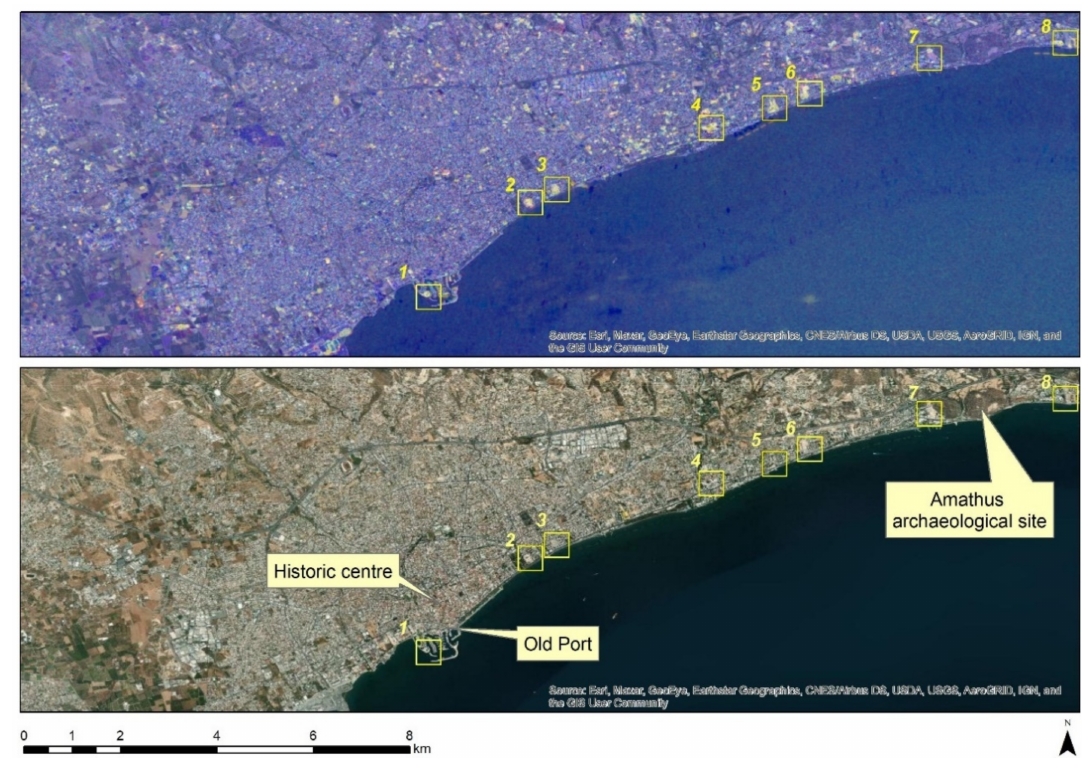
Figure 4. Top: VV and VH polarisation visualisation change detection during the period 2015–2020 over Limassol city. Bright colours indicate areas of changes during this period. Bottom: The same are using as a background a high-resolution satellite image (source: ArcGIS Basemap). Examples from these changes are provided in Table 1 for the selected areas indicated with a yellow square (no. 1–no.